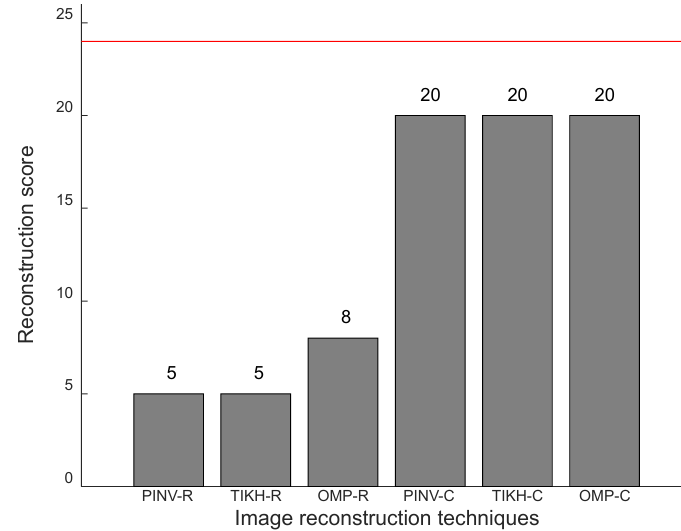
Figure 14. Reconstruction scores with two obstacles in the